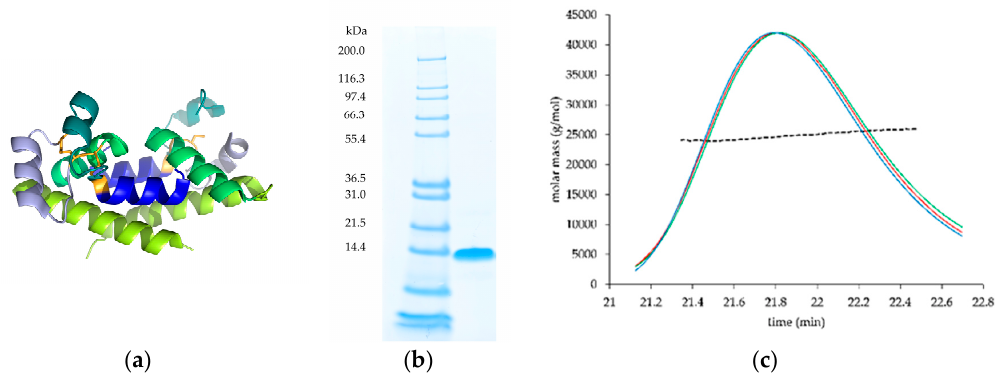
Figure 1. The wild-type human CD81 large extracellular loop (hCD81 LEL). ( a ) Crystal structure of hCD81 LEL (PDB 1G8Q). Lemon: helix A; green: helix B; light blue: helix C; teal: helix D; deep blue: helix E; orange: native cysteine bridges. The figure was prepared with PyMOL (PyMOL Molecular Graphics System, Version 1.3 Schrödinger, LLC); ( b ) SDS-PAGE of purified hCD81 LEL; ( c ) Multi-angle light scattering (MALS) analysis of purified hCD81 LEL. Black dashed line: molar mass; red: light scattering detector trace; green: UV detector trace; blue: refractory index detector trace.